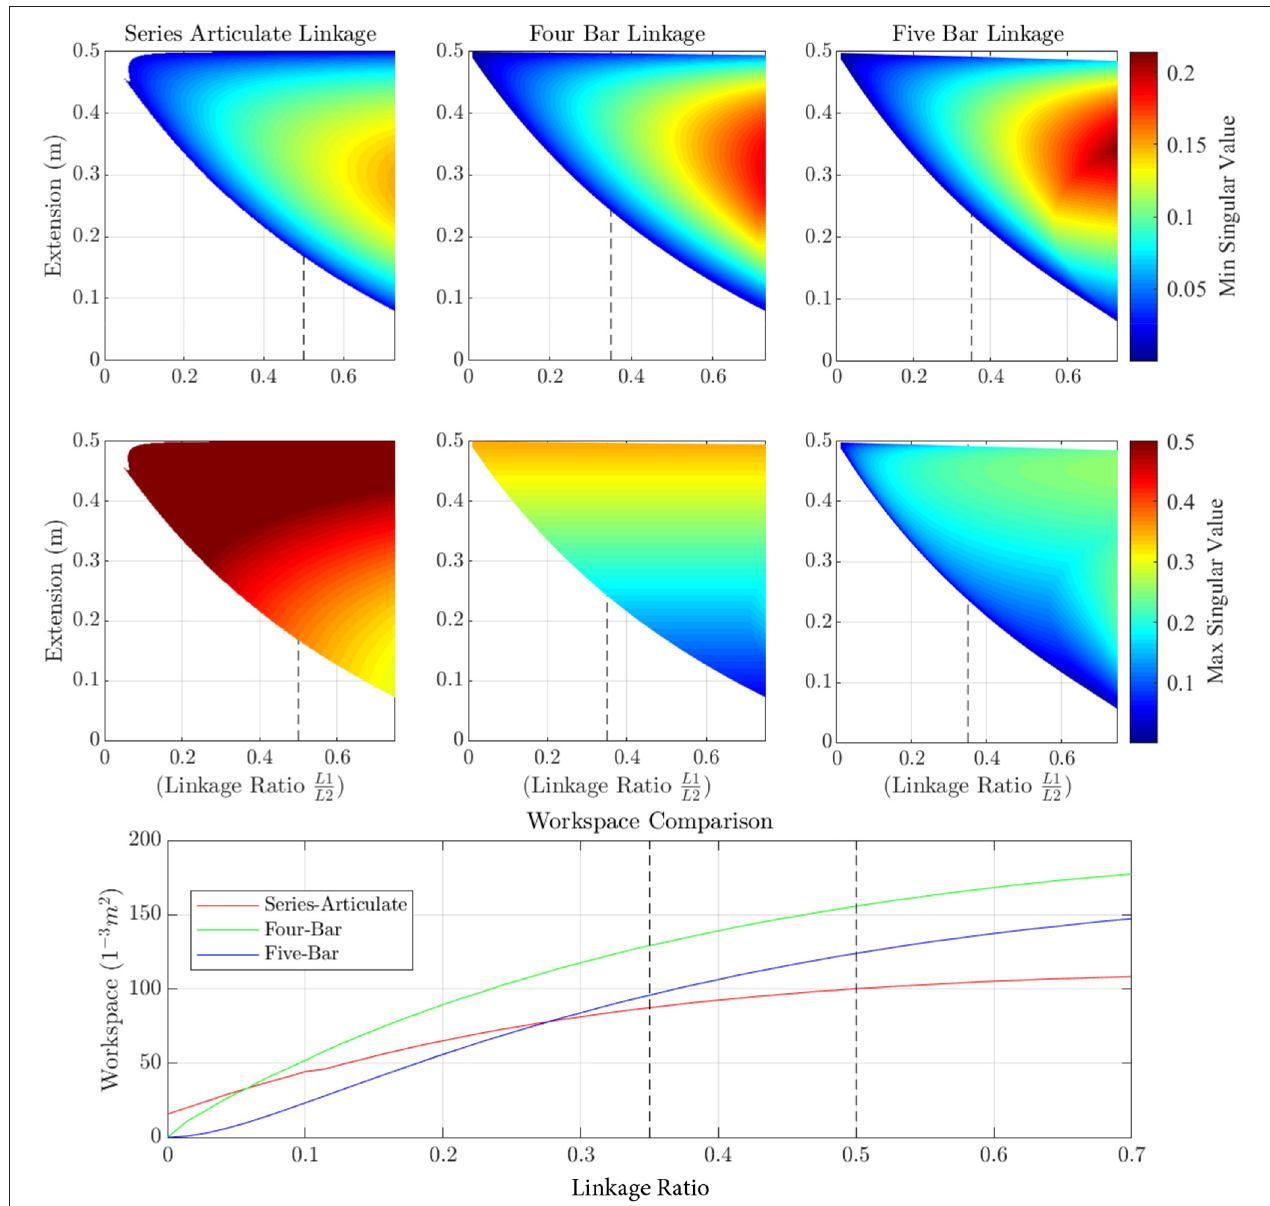
FIGURE 2 | The singular values for each linkage mechanism (series articulate, four-bar and five-bar linkages) are shown. The minimum singular value should be maximized to make the end effector forces more visible to the motors. The maximum singular value should be minimized to improve the torque requirements at the motor to generate a force at the foot, resulting in a trade-off. The bottom graph also shows how the workspace changes with change in linkage ratio. From these graphs it is clear that the four- and five-bar mechanism offers the best performance in terms of visible forces on the motor and torque requirements to generate the required force. As soon as the linkage ratio is above 0.3, the four- and five-bar mechanisms also offers the best workspace capabilities. The dotted lines show the optimal ratio for each linkage system, with the four- and five-bar linkages being roughly the same at a linkage ratio of 0.35 and the series articulate being optimal at